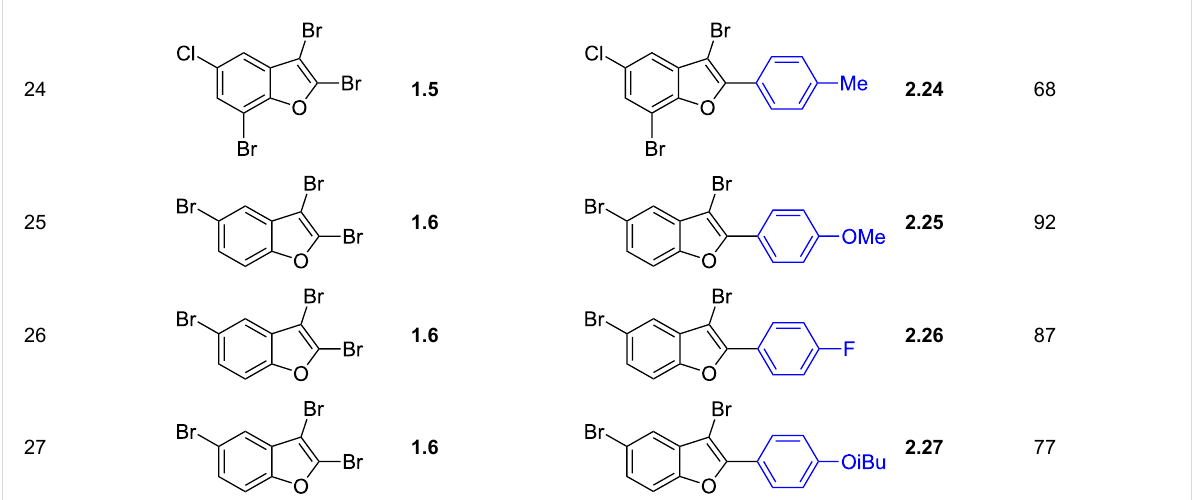
Table 2: Cross-couplings of 2,3-dibromobenzofurans with BiAr 3 reagents. a (continued)